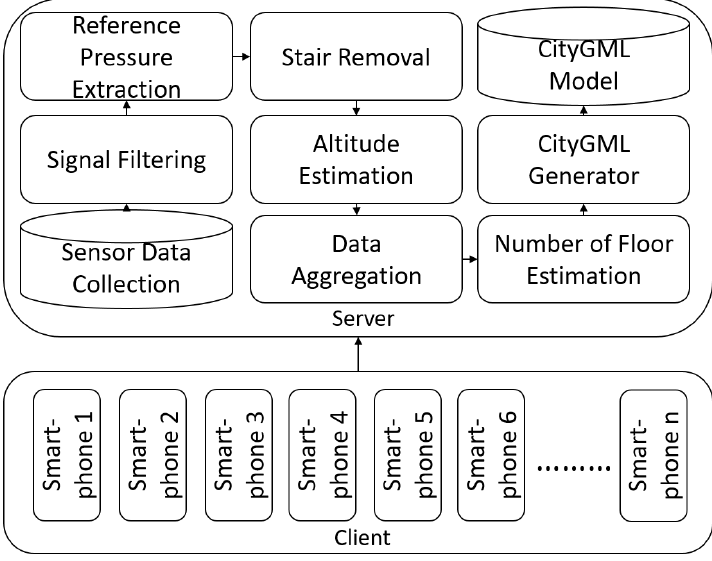
Figure 1. The overall architecture of our system